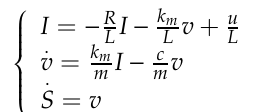
Figure 9. Gas force acting on the exhaust valve.